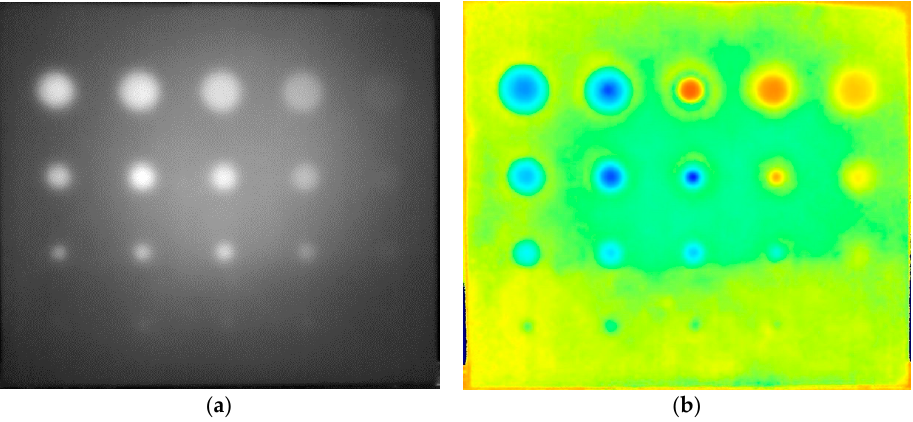
Figure 9. ( a ) Raw thermogram and ( b ) phase image (acquisition time = 53.2 s) obtained from the thermal image sequence recorded during cooling after flashing the surface.